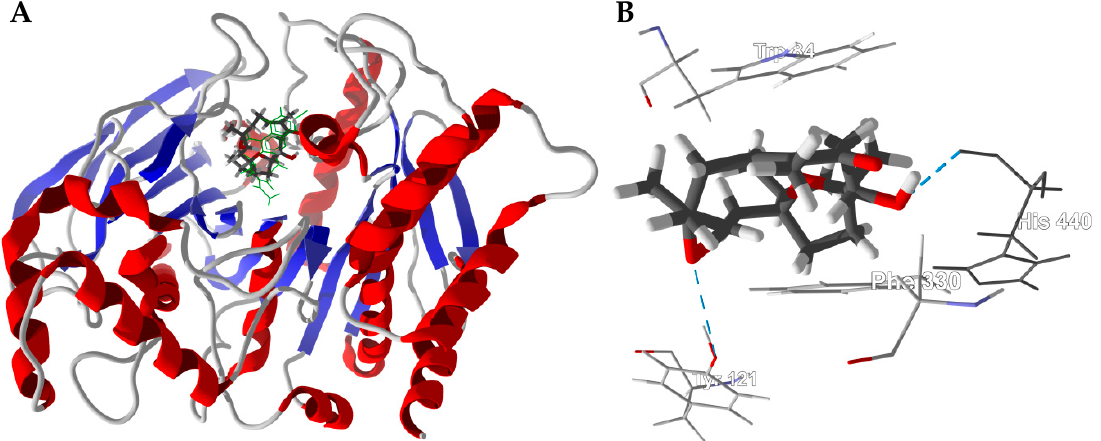
Figure 4. Lowest-energy docked pose of boscartin G with Torpedo californica acetylcholinesterase (TcAChE, PDB 1e66). ( A ): Ribbon structure of TcAChE with boscartin G in the active site; the co-crystallized ligand (huprene X) is shown as a green wire figure. ( B ): Key interactions of boscartin G with amino acids in the active site of TcAChE; hydrogen bonds are shown as blue dashed lines.